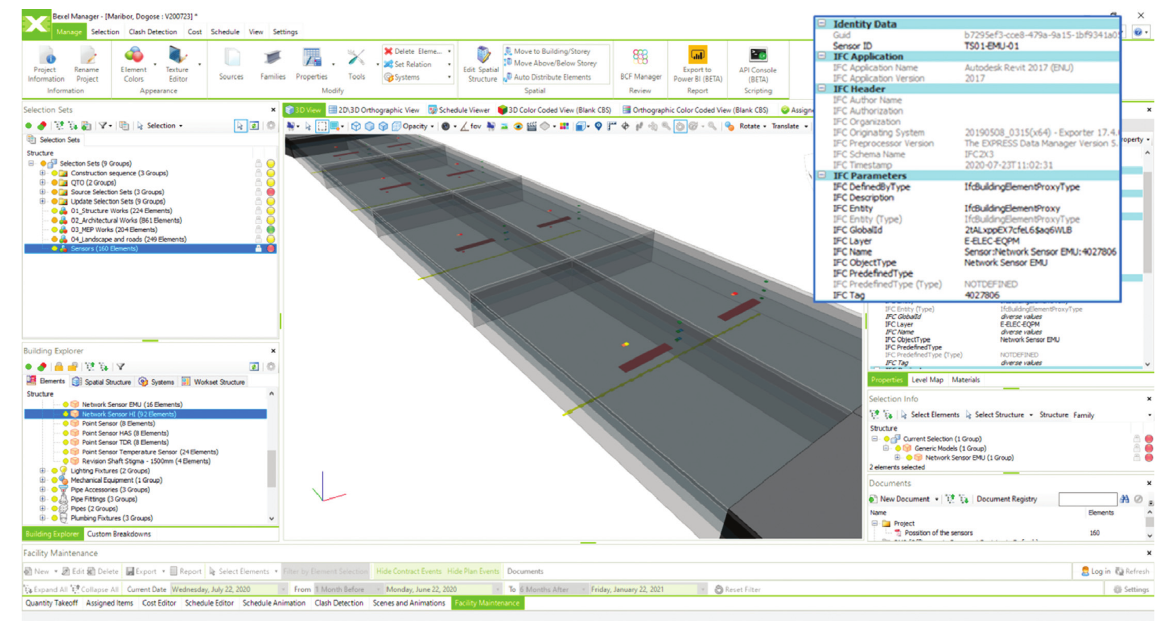
Figure 6: Federated BIM. Table 1: Implemented sensors, types, and position in the road cross section.